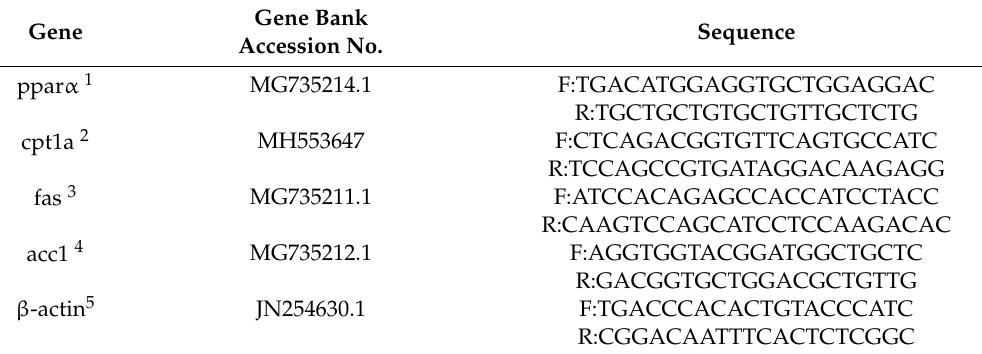
Table 3. Forward and reverse primers’ sequences used for real-time quantitative